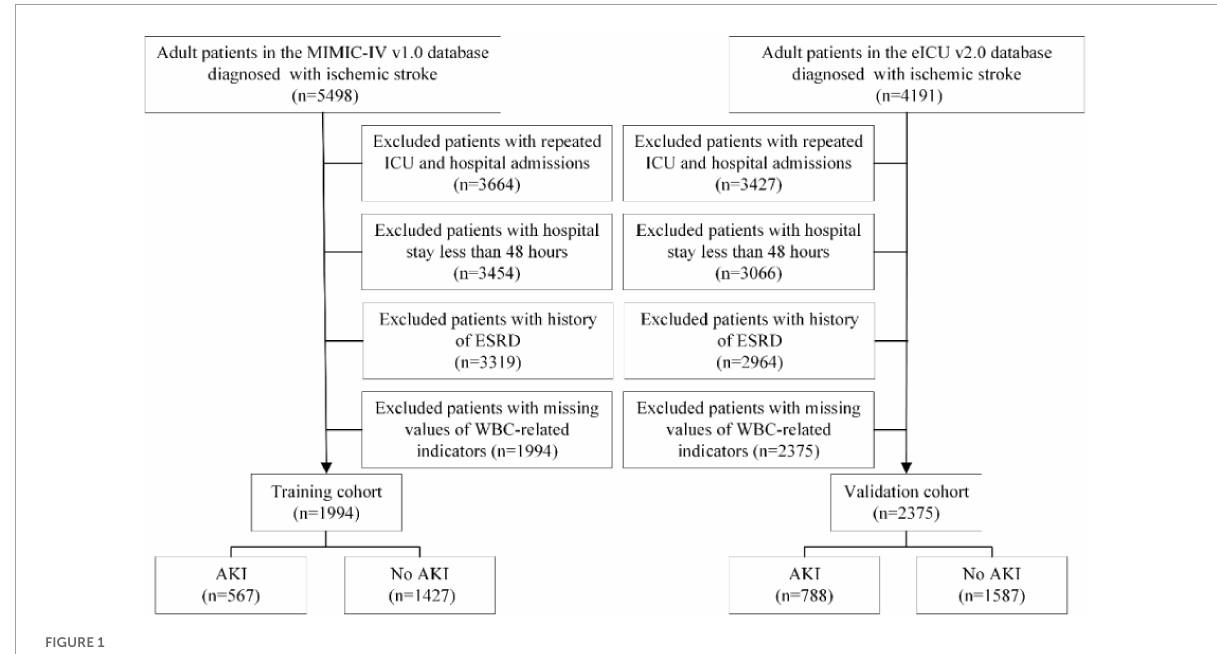
FIGURE1 The flow chart of this study.